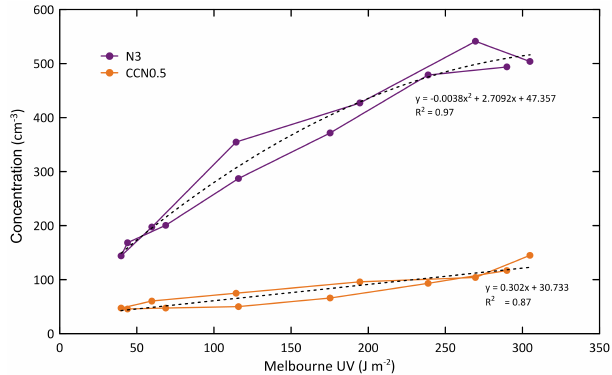
Figure 7. Melbourne UV 1976–2008, median CCN with radon <150mBeqm − 3 1981–2006 and median